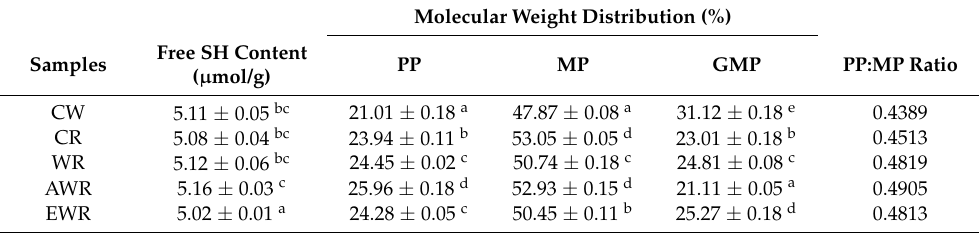
Figure 2. Molecular weight distribution of SDS-soluble proteins from red bean dough analyzed by SE-HPLC. Fractions: polymers (91–688 kDa, F1), monomers (10–91 kDa, F2) and peptides and amino acids (under 10 kDa, F3). Where, A (a), B (b), and C (c) represented peak separations at different magnification for dough samples. Table 2. The effect of EPS formed in red bean sourdough on molecular weight distribution of gluten proteins and free SH content of wheat–red bean